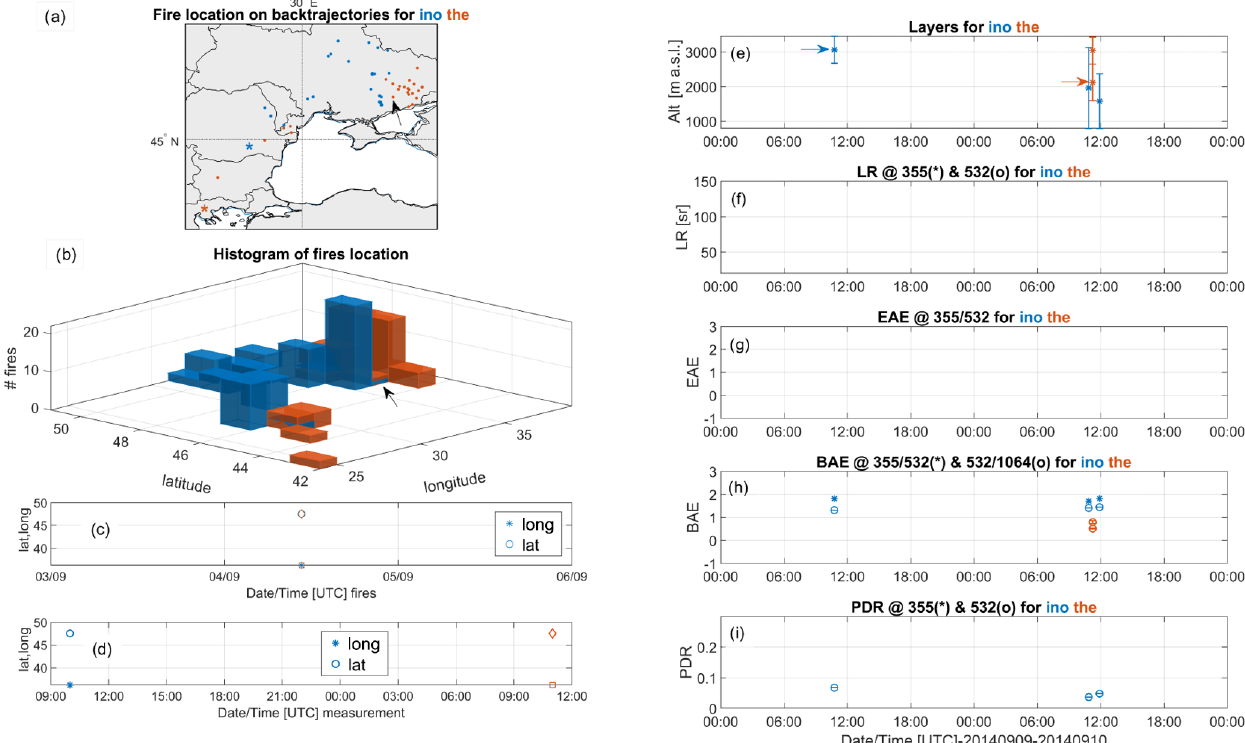
Figure 7. Measurements with the same source in Thessaloniki (“the”) and Bucharest (“ino”) on 9 and 10 September 2014. (a) Fire locations seen during back trajectories from each station (colour coded). (b) Histogram of the fire occurrence in each geographical grid. (c) Longitude and latitude of the common fire location versus fire occurrence time. (d) Longitude and latitude of the common fire location versus measure- ment time at the two locations. (e–i) Smoke layer altitude and intensive parameters for each station. Layers measuring the common fire are shown by arrows. The geographical location of the common fire is shown in the histogram by an